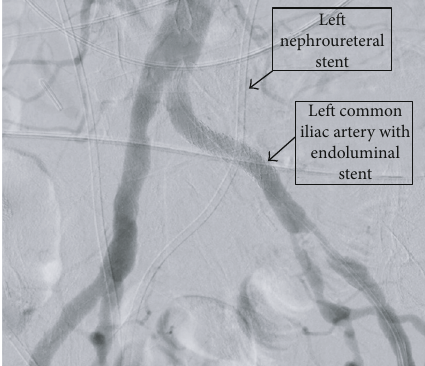
Figure 2: Arteriogram following endograft placement with no contrast exiting the arterial system. Left nephroureteral stent is noted traversing the location of graft placement highlighting the region of fi stula